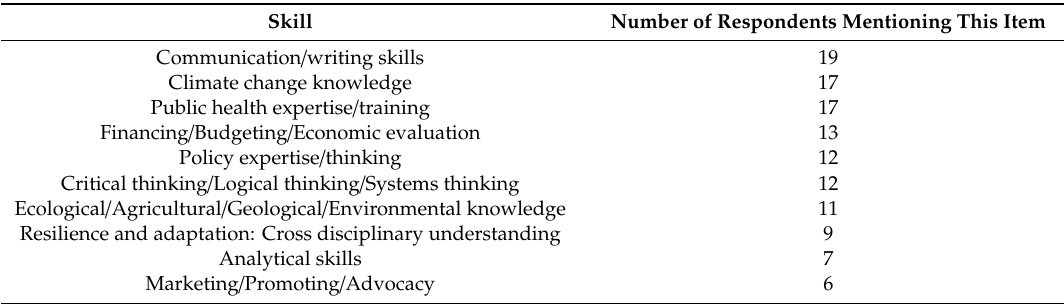
Table 6. Open-ended survey